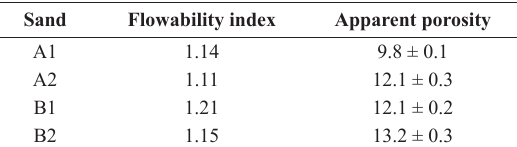
Table III. Flowability index (raw materials) and apparent porosity (after firing) of the filler sands. Sand